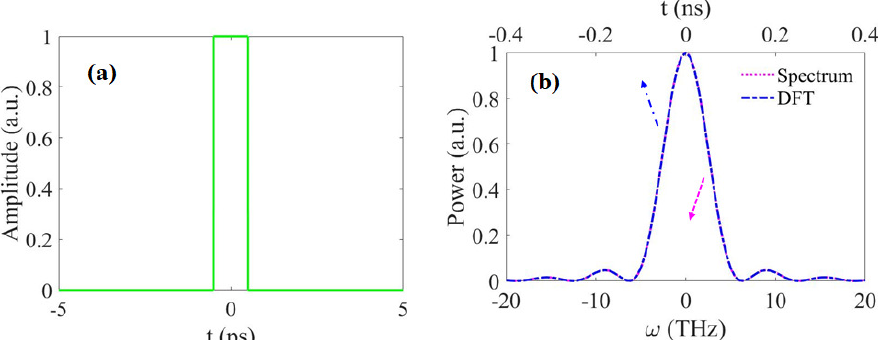
Figure 5. Time and frequency domains of a rectangular pulse (Original pulse width = 1 ps): ( a ) Temporal profile of the rectangular pulse; and ( b ) spectrum and dispersive Fourier transformation of the rectangular pulse after the prism pair. The pink dotted line and blue dash-dotted line represent the spectrum and dispersive Fourier transformation of the rectangular pulse, respectively. The light beam transfers in the prism pair with 20 m total length and 0.5 ◦ propagation angle, and the central wavelength of the beam is fixed at 2.05 µ